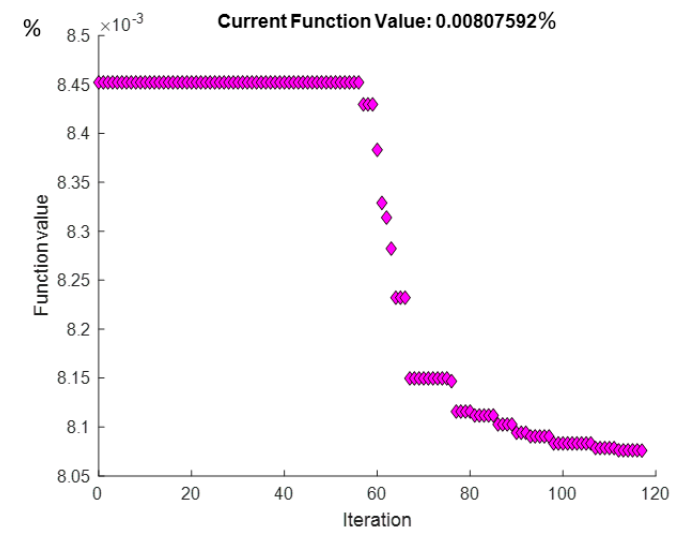
Figure 2. Reduction of the maximal relative error during the optimization process for Equation (6) of [1]. Thus, this procedure reduces the maximal absolute relative error of Equation (5) of [1] from 0.00845% to 0.00807592%.